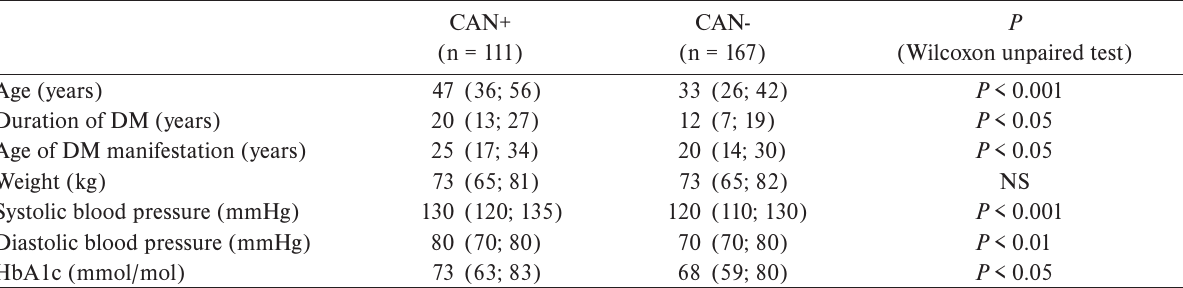
Table 1. Baseline characteristic of group CAN+ and CAN-.